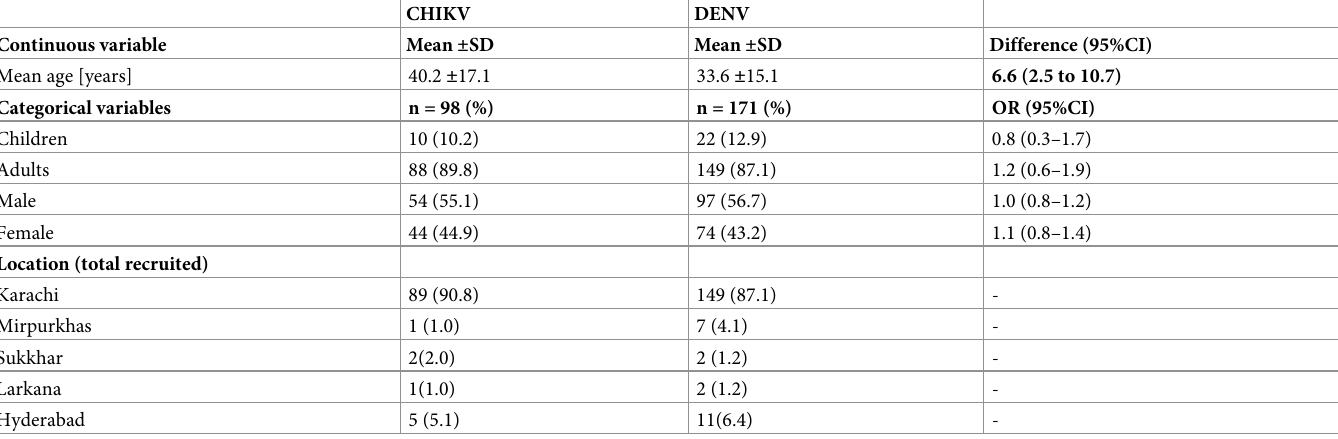
Table 1. Demographics of patients diagnosed with either DENV or CHIKV. Bold font indicates statistical